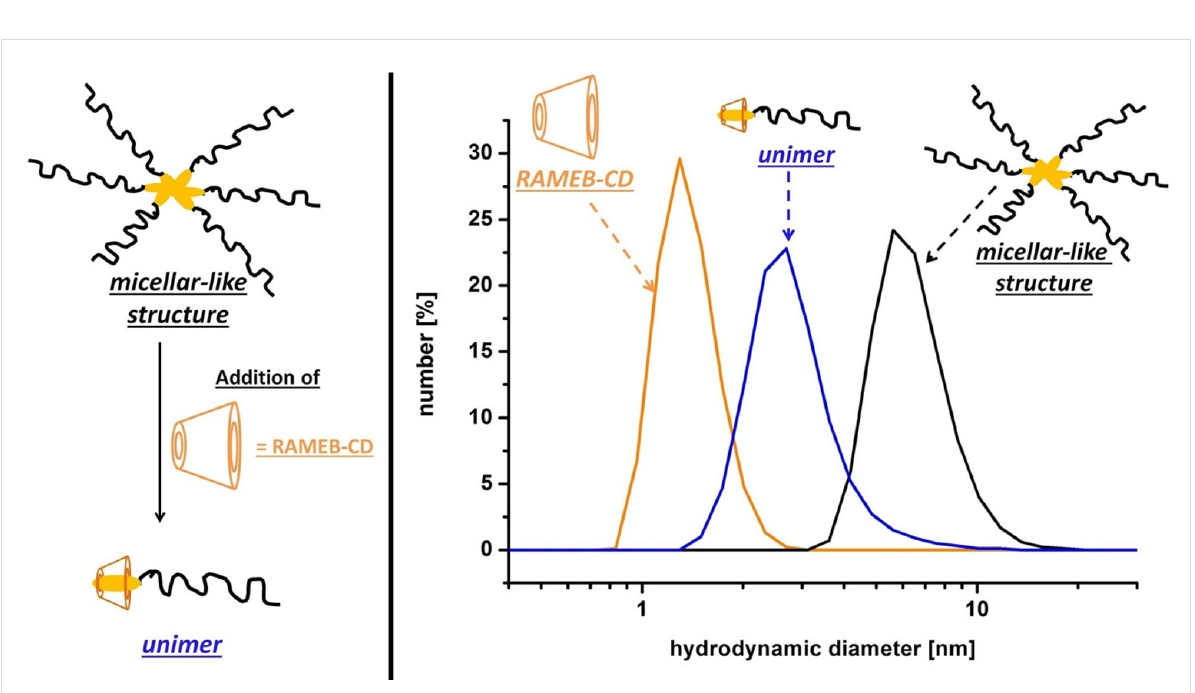
Figure 8: Left: Schematic illustration of the micellar-like structures and reversibility by addition of RAMEB-CD; Right: DLS measurements size distrib- utions for RAMEB-CD (orange line), 9c (black line) and 9c plus 1 equiv RAMEB-CD (blue line).